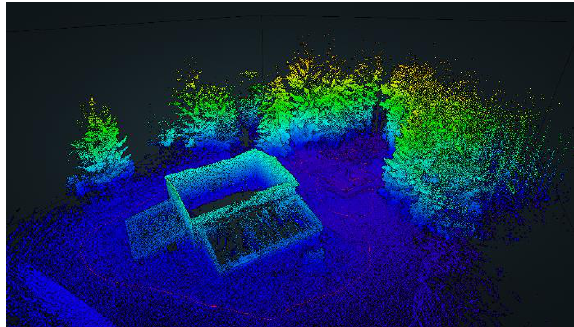
Figure 17. Nearby historical mining relicts from sixteenth- seventeenth century, an abandoned relict on Uranium mining can be found (ZEB-REVO PLS)